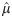
Two-piece normal detection model for black bears in Skwetna study area of South-Central Alaska.The detection curve is for averaged covariate values of binned search distance, percent cover, and transect type. The vertical line at 102.6 m depicts μ^. The histogram is of the observed black bear group detection distances.